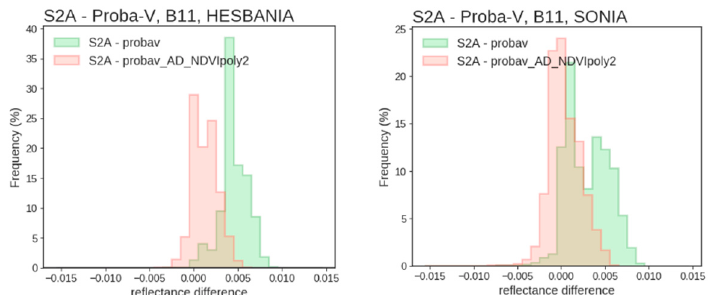
Figure 4. Bias histogram between the SWIR band of PROBA-V and B11 of S2A, original data (green), and after applying the selected RSRF correction function AD_NDVIpoly2 (red), for the agricultural HESBANIA ( left ) and urban SONIA ( right ) images.